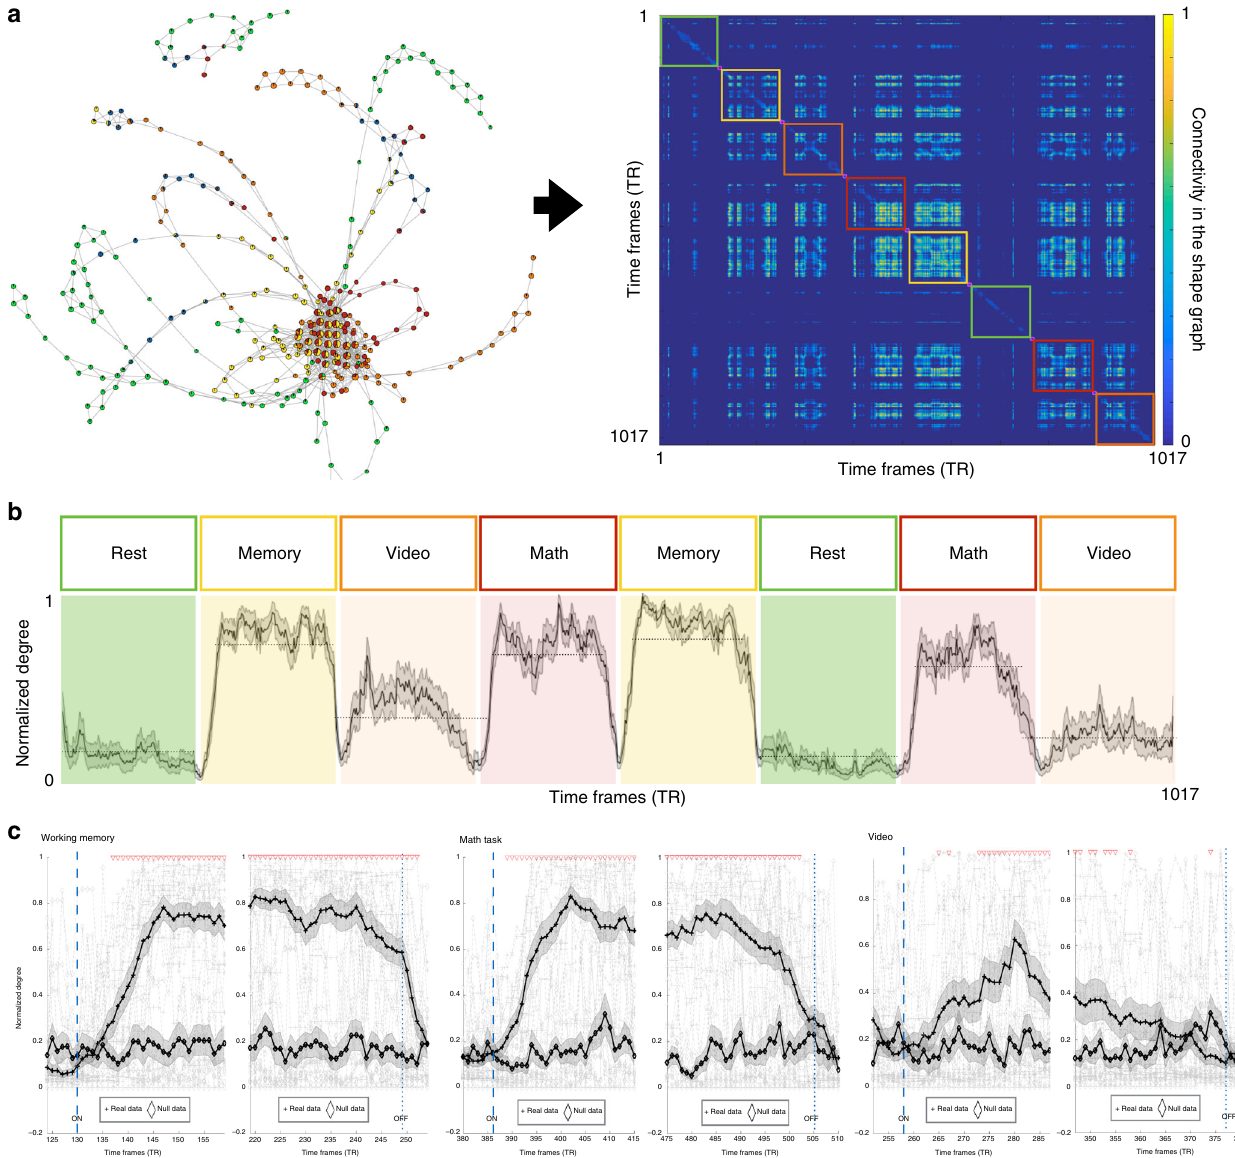
Fig. 5 Capturing temporal transitions at the level individual time frames. a Shows a temporal connectivity matrix (TCM) for participant S 01 from the CMP dataset. A TCM (size: #time frames× #time frames) shows how each time frame is connected (or similar) to all other time frames. The time frames are connected (i.e. non-zero value in the TCM) if they share a node in the shape graph or if the nodes containing these time frames are connected by an edge in the shape graph. We have manually highlighted the task blocks on the TCM to show the task-related modular structure. b Shows that the degree of TCM nodes can capture the transition between tasks. Here we show average degree across all 18 participants as a solid-line, shaded region shows the standard error around the mean. The dotted lines denote detected change points, which mark the transitions for the eight task blocks. c Shows the effectiveness of capturing temporal transitions extracted from the CMP data as compared to transitions extracted from the phase-randomization null model. The blue dashed line denotes onset of task block and the blue dotted line indicates offset of task block. As compared to the null model data (denoted using diamonds), a time frame by time frame analysis revealed that the degree of TCM generated using real data (denoted using + signs) could capture both the onset and offset of each task within a matter of a few time frames. The red inverted triangles on top denote point-by-point signi fi cant difference between transitions from real as compared to null and lateral occipital cortex, and paracingulate gyrus. Higher assessment was performed by overlaying the observed results on coreness scores during the math task were associated with the meta-analysis maps generated by NeuroSynth.org 44 for each task term (i.e., “ working memory, ” “ arithmetic, ” and “ object increased engagement of the R. angular gyrus, inferior parietal recognition, ” respectively). For the negative association contrast, sulcus areas and the paracingulate gyrus. Lastly, for the video across all three tasks, signi fi cant clusters were observed in the task, higher coreness scores were positively associated with posterior cingulate cortex (PCC) and medial prefrontal cortex activation in the bilateral fusiform gyrus and right frontal pole. (Supplementary Fig. 5), suggesting nodes with lower coreness Qualitatively, the brain regions associated positively with coreness scores (i.e., periphery nodes) were associated with increased scores largely overlapped with regions previously shown to be activation in the PCC irrespective of the task type. No signi fi cant recruited for the respective tasks (Fig. 4c). This qualitative